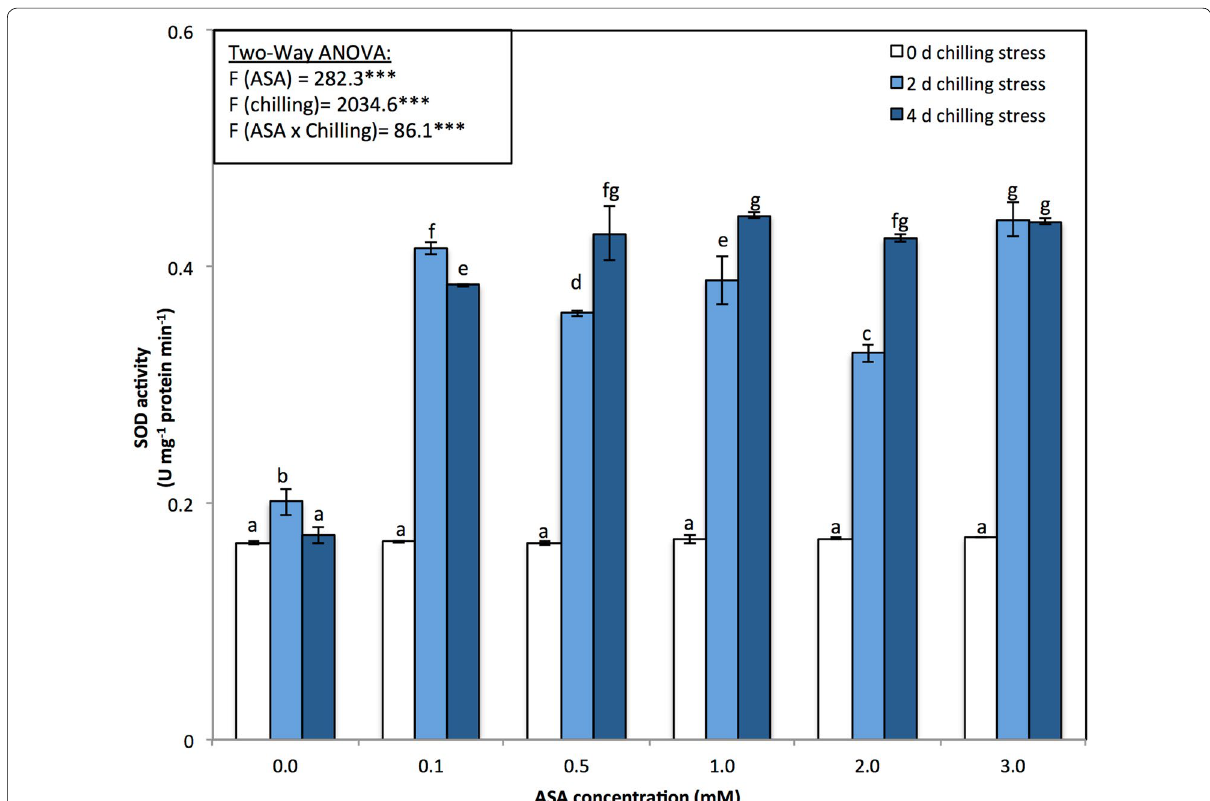
Fig. 6 Superoxide dismutase activities (unit mg − 1 protein min − 1 ) of P. vulgaris L. after foliar application of different concentration of acetylsalicylic acid (ASA; 0, 0.1, 0.5, 1, 2, 3 mM) and exposed to different level of chilling stress (0, 2, 4 days). Data represented are mean of two replicates ard deviation. Variations between different chilling stresses and foliar ASA concentration were assessed by univariate analyses followed by post hoc analysis. Means with the same letters are not significantly different according to Duncan’s multiple